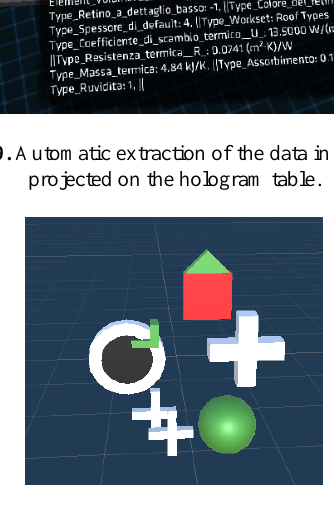
Figure 10 . Tools implemented on the